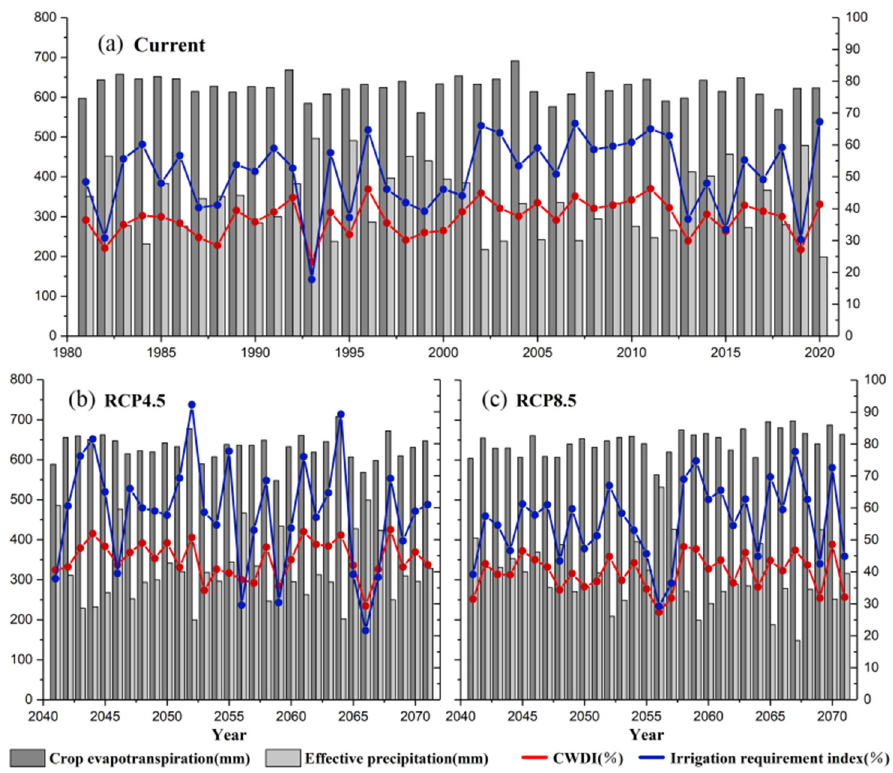
Figure 10. Annual trends in maize water supply and demand.